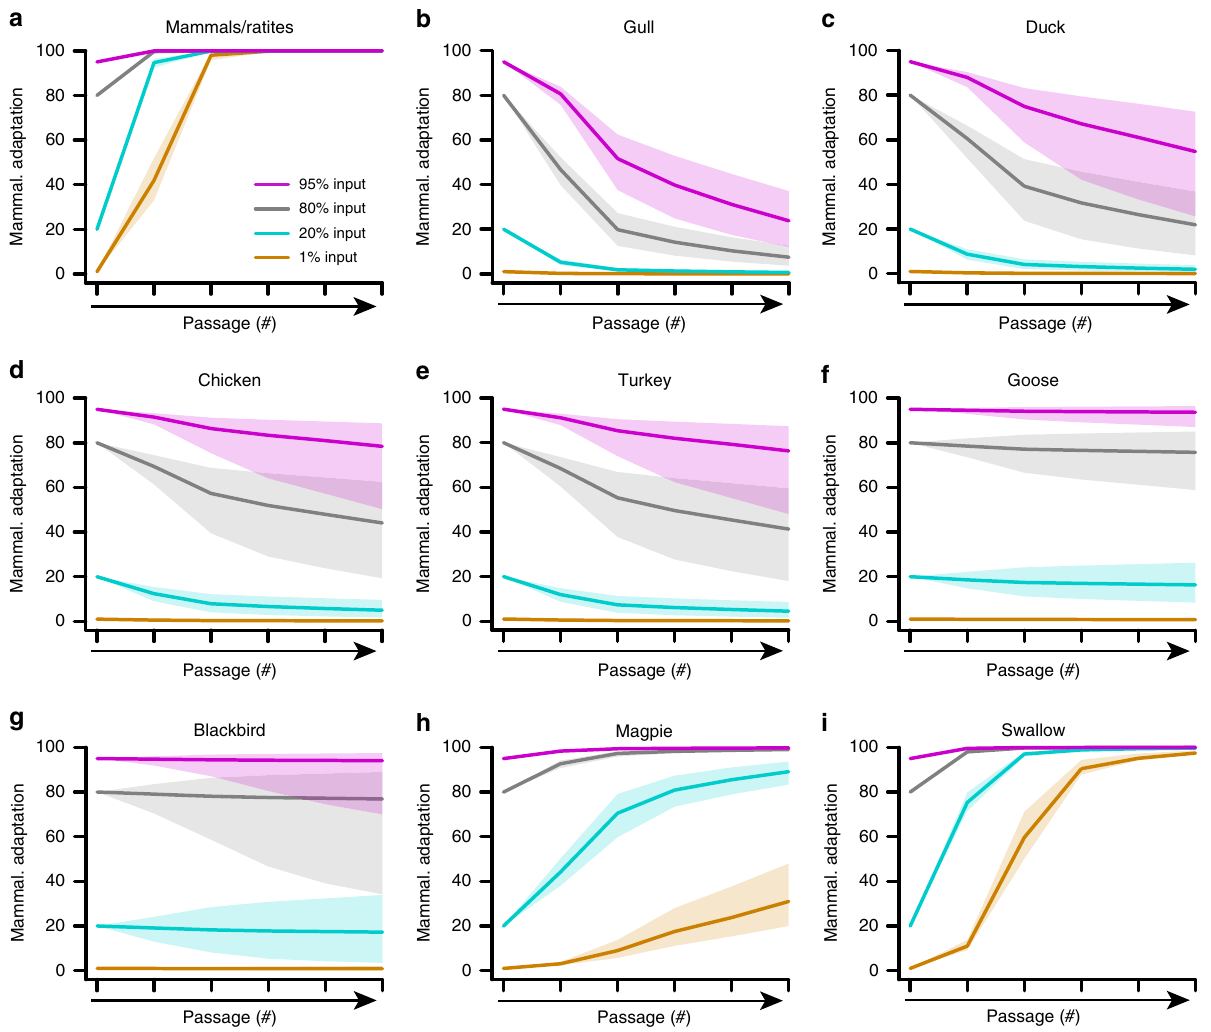
Fig. 5 Modeling the impact of species ’ ANP32A splice variant ratios on selection of mammalian- or avian-like IAV adaptations. a – i Model predictions of mammalian-like vPol selection in the indicated species, taking into account their ANP32A splice variant ratios as shown in Fig. 3a. Each input mammalian- like vPol percentage assessed is indicated by a separate color. The solid lines indicate the model prediction with the best estimates of virus production rates, and the lighter areas show the 95% bootstrap con fi dence